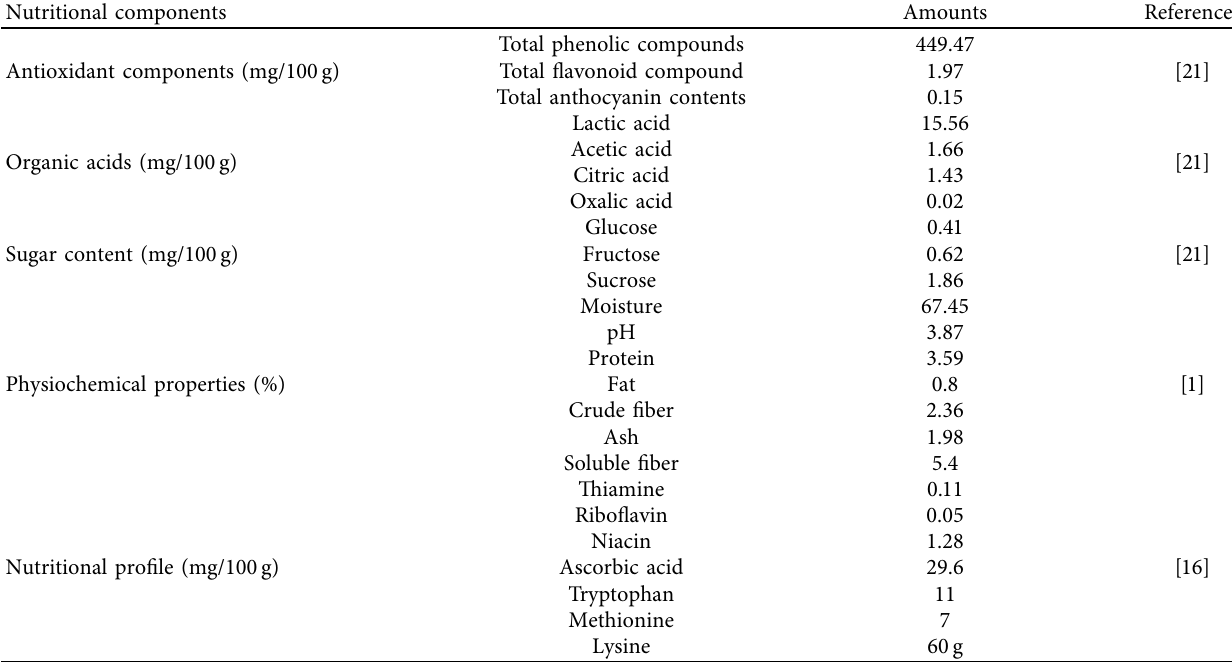
Table 1: Nutritional value of the soursop